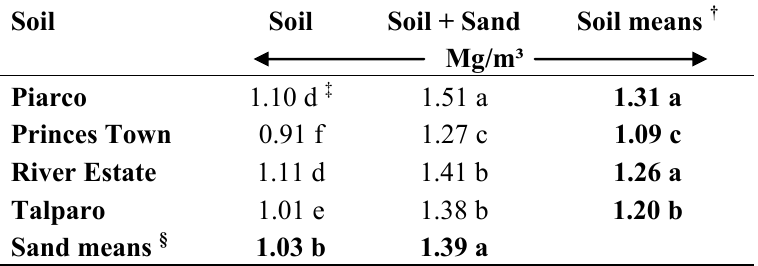
Table 6. Sand layering influence on root zone BD across four soils.